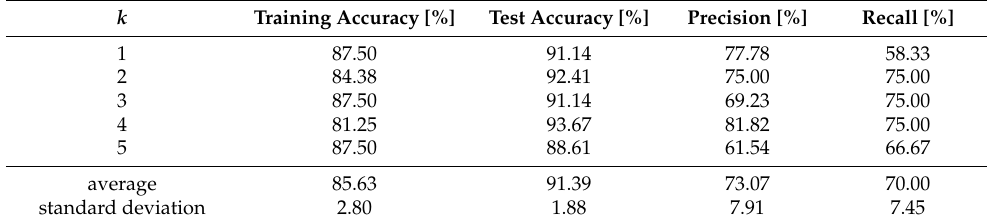
Table 2. Prediction results using only data before knocking.